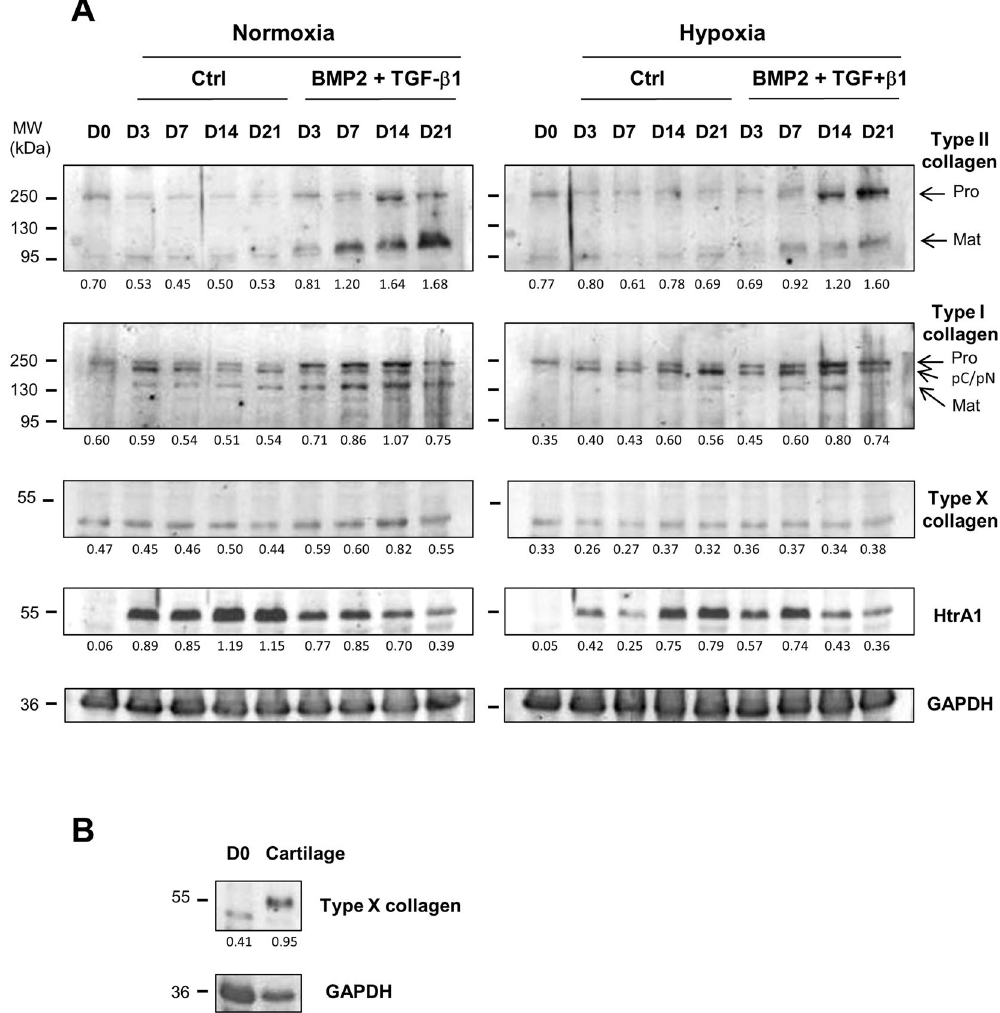
Figure 5. Effect of culture conditions on collagen and HtrA1 synthesis. hBM-MSCs were cultured in type I collagen sponges for 0, 3, 7, 14, and 21 days under normoxia or hypoxia, in the absence (Ctrl), or presence of both 50 ng/mL BMP-2 and 10 ng/mL TGF- β 1. Protein extracts were analyzed by Western-blotting for type I, II, and X collagen, and HtrA1 versus GAPDH ( A ). Protein extracts from undifferentiated MSCs at day 0 (D0) and a macroscopically healthy zone of human OA cartilage were also analyzed by Western-blotting for type X collagens versus GAPDH ( B ). Different exposures of the blots are provided in the supplementary information file (Fig. S5). Corresponding quantifications of the bands of interest, normalized to the GAPDH signals, are shown as arbitrary units below each blot. Representative blots are